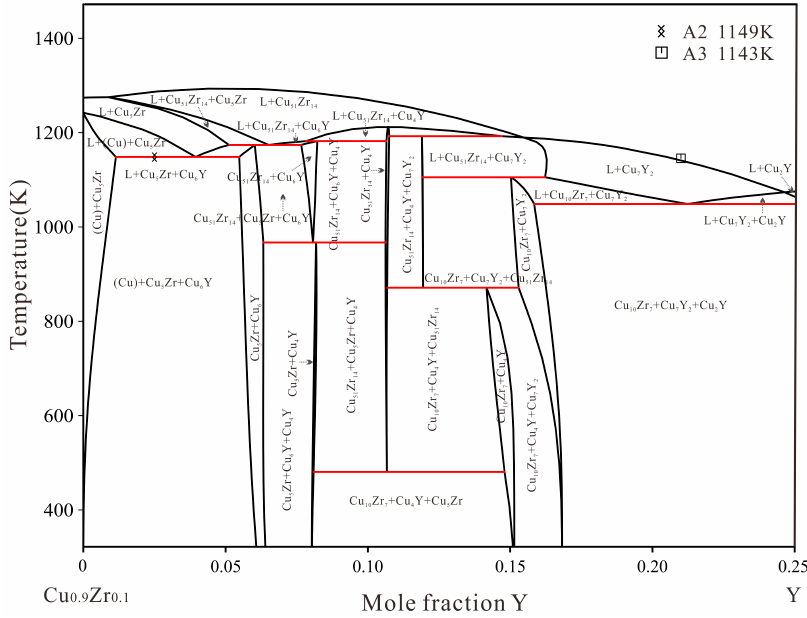
Figure 11. Calculated vertical section of the Cu–Zr–Y system at 10 at.% Zr with the experimental